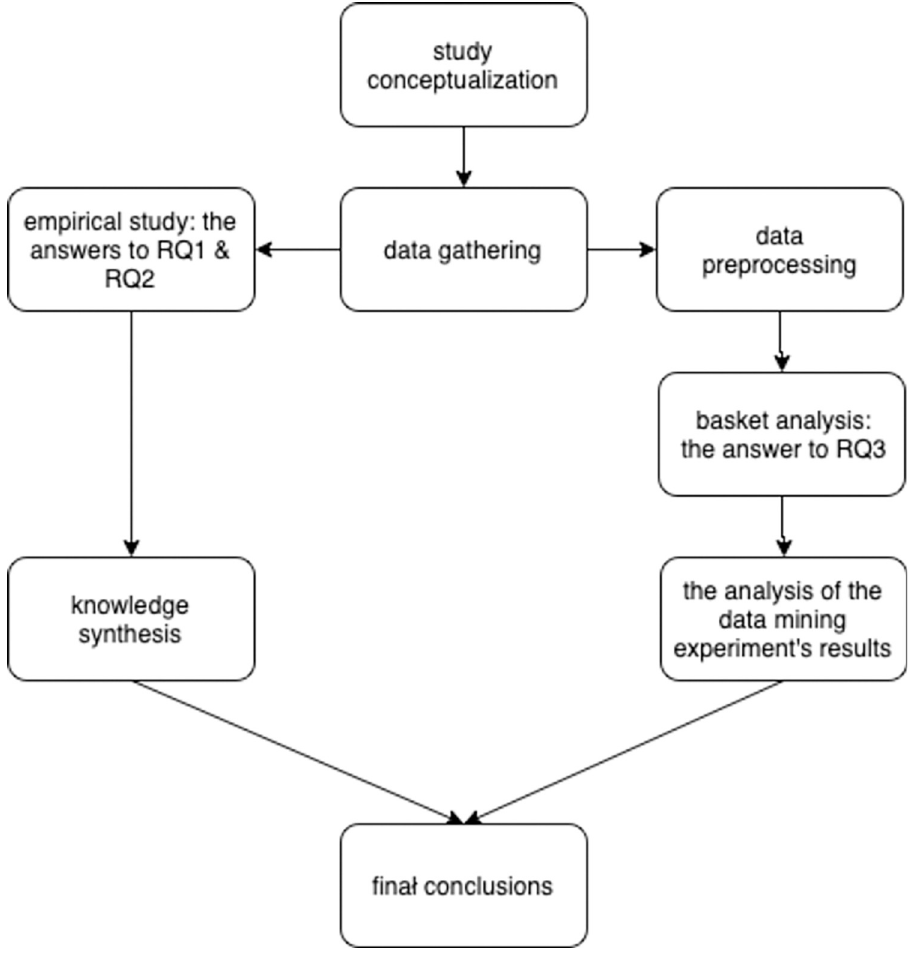
Fig 4. The course of the experiments presented in this